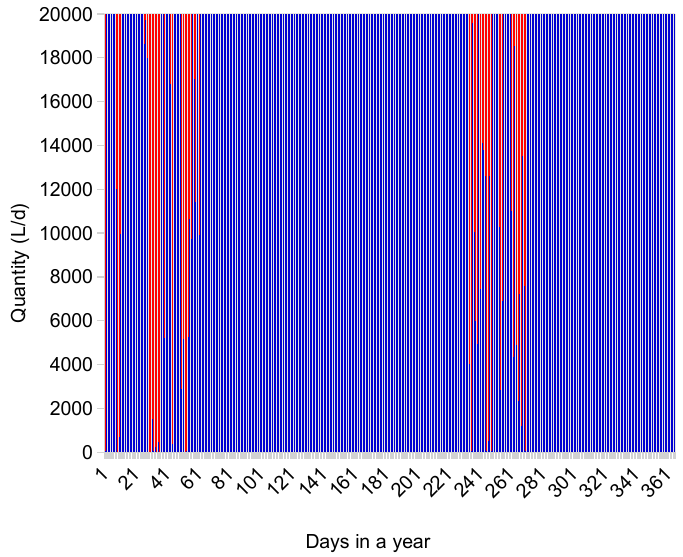
Figure 7. Daily requirements supplied through RWH (blue bars) and the corresponding required supplementary supply (red bars) to meet a demand of 20,000 L d − 1 for a given hotel industry for a catchment area of 15,000 m 2 . Note that for any given day, the demand that is not met through RWH, is met through supplementary sources to meet the total demand (i.e., 20,000 L d − 1